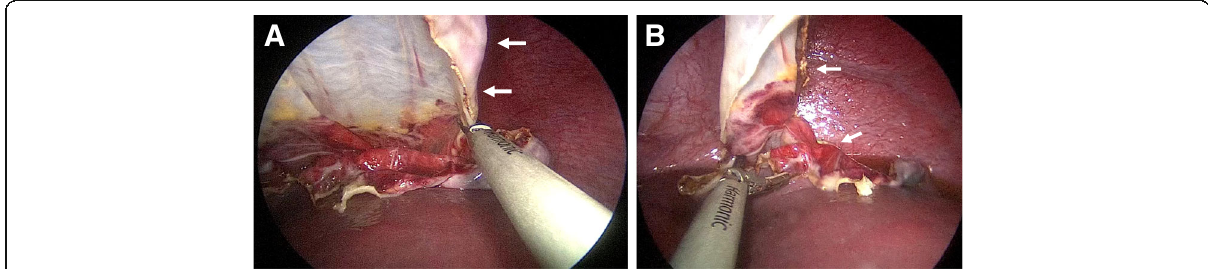
Fig. 2 a , b The protruding part of the cyst wall (white arrow) was entirely resected using a USAD at the border of the splenic